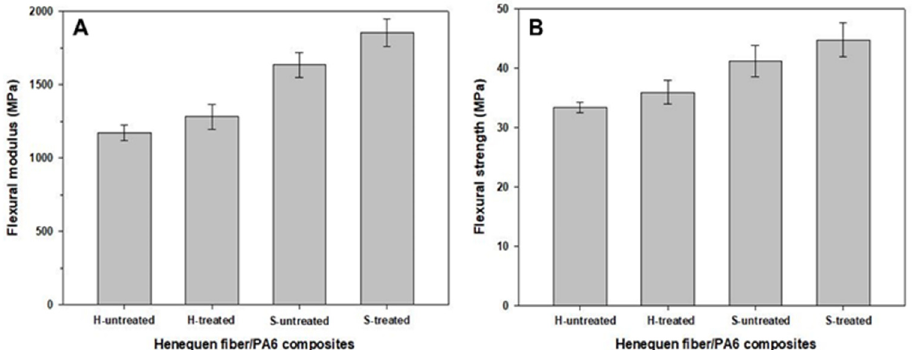
Figure 10. Flexural modulus ( A ) and strength ( B ) of untreated and alkali-treated henequen fiber/PA6 composites produced via different fiber feeding routes.